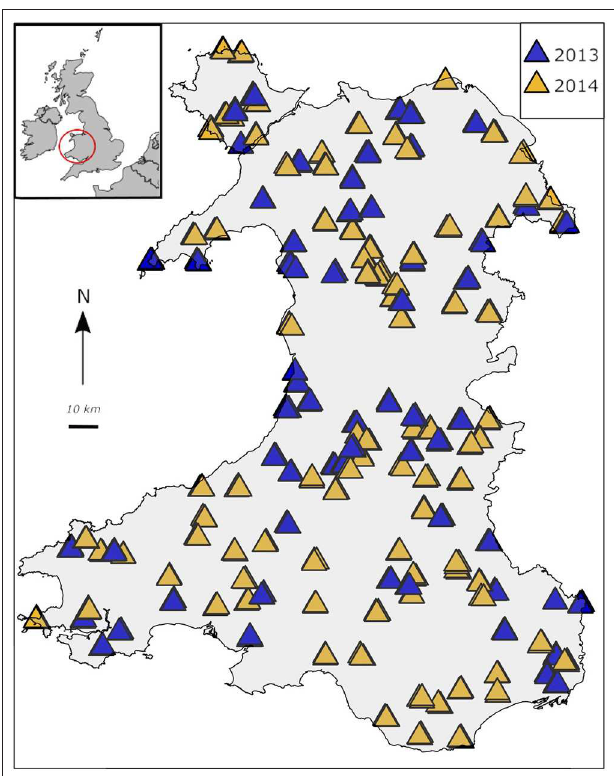
FIGURE 1 | Map of sites selected for GMEP monitoring. To protect landowner anonymity, each triangle gives an approximate location of every 1 km 2 plot from which samples were